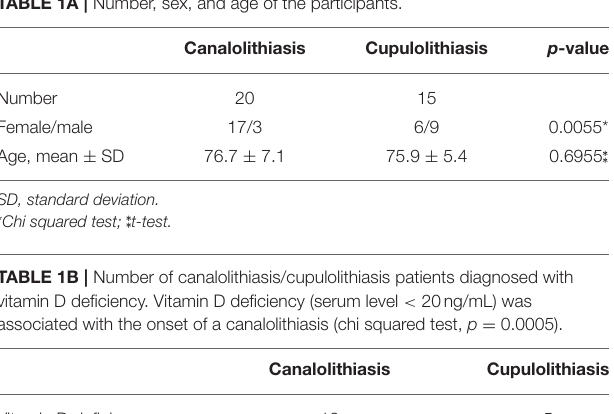
TABLE 1A | Number, sex, and age of the